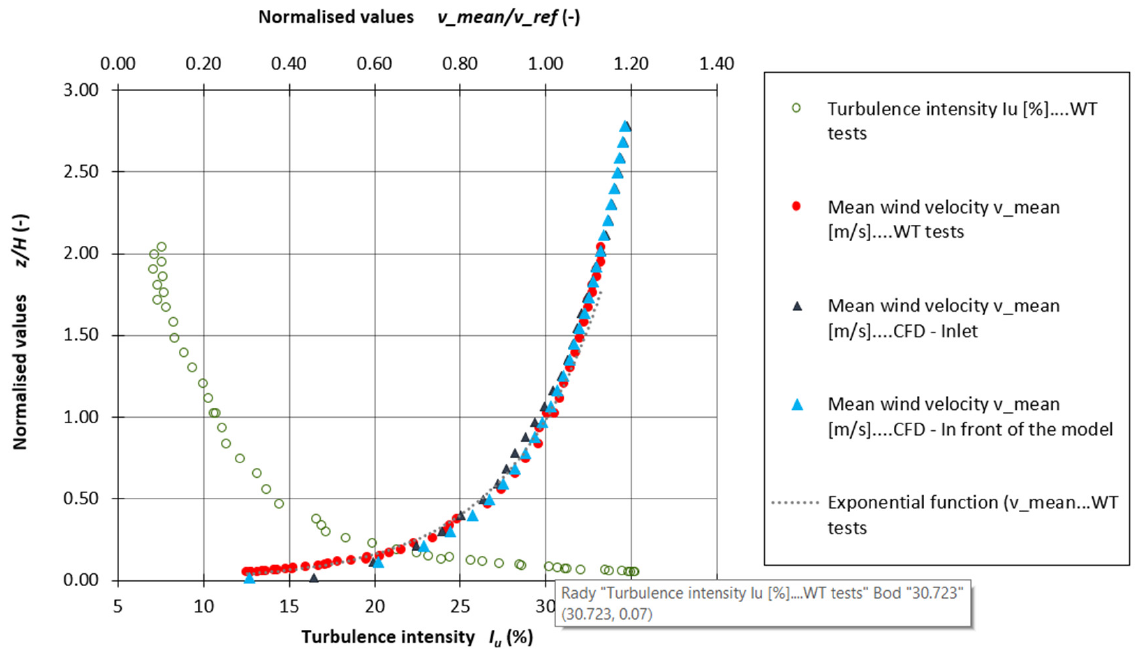
Figure 9. The profiles of mean wind velocity and the profile of turbulence intensity (where H = 0.540 m is the total height of the model, and v ref = 10.951 m/s is reference wind